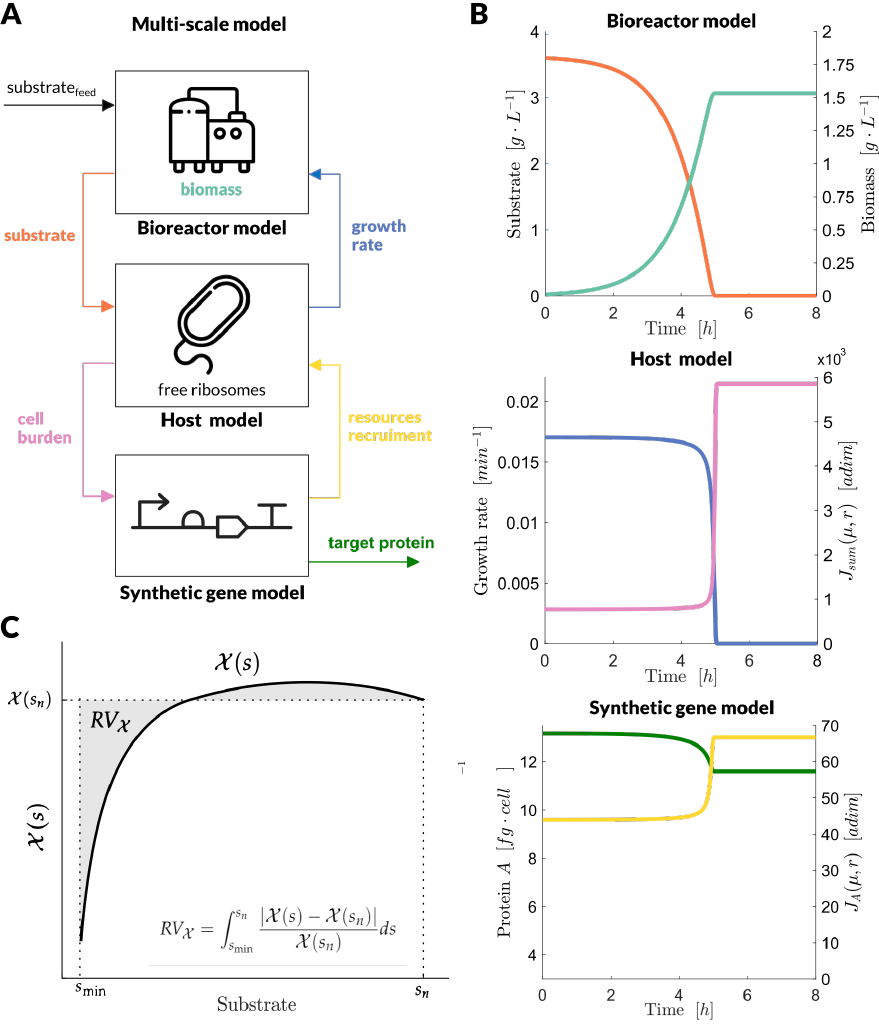
Figure 1. Bioprocess multi-scale model. ( A ). Schematic representation of the multi-scale model. The three levels considered including the bioreactor, the host cell and the synthetic circuit models and their interactions. ( B ). Simulation obtained with the multi-scale model. The colors correspond to the interactions in panel (A). An example of a batch operation, where the synthetic circuit parameters = 5 and K A = 117. Top panel shows the macroscopic scale with the substrate are ω A = 50, k A u b availability (left axis) and biomass concentration (right axis). Middle panel shows the growth rate (left axis) and a measure of the cell burden (right axis). Bottom panel shows the amount of protein A expressed in a cell (left axis) and its resource recruitment strength J A (right axis). ( C ). TRY relative variation indices for substrate variations. Shaded area RV χ represents the integral from minimum substrate s min to the nominal substrate s n of the difference between the nominal index value and the actual